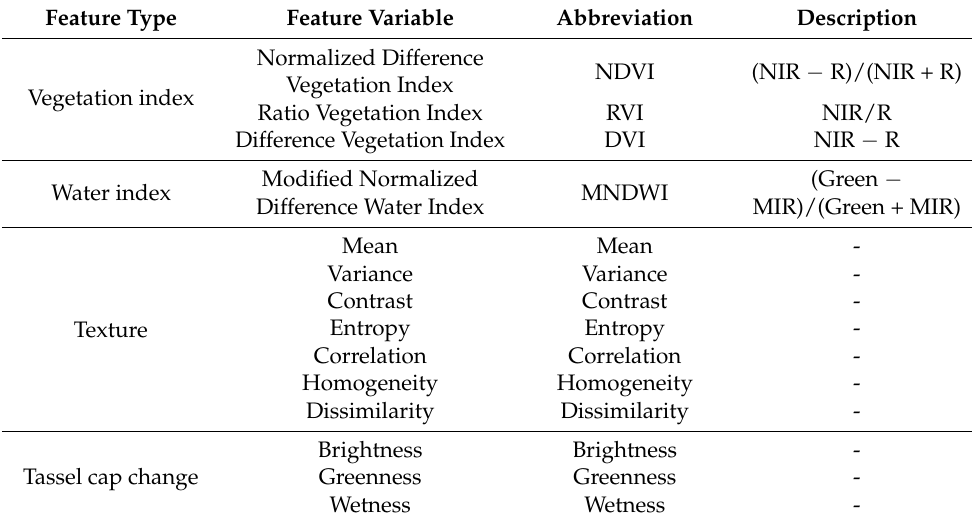
Table 3. Landsat date feature type